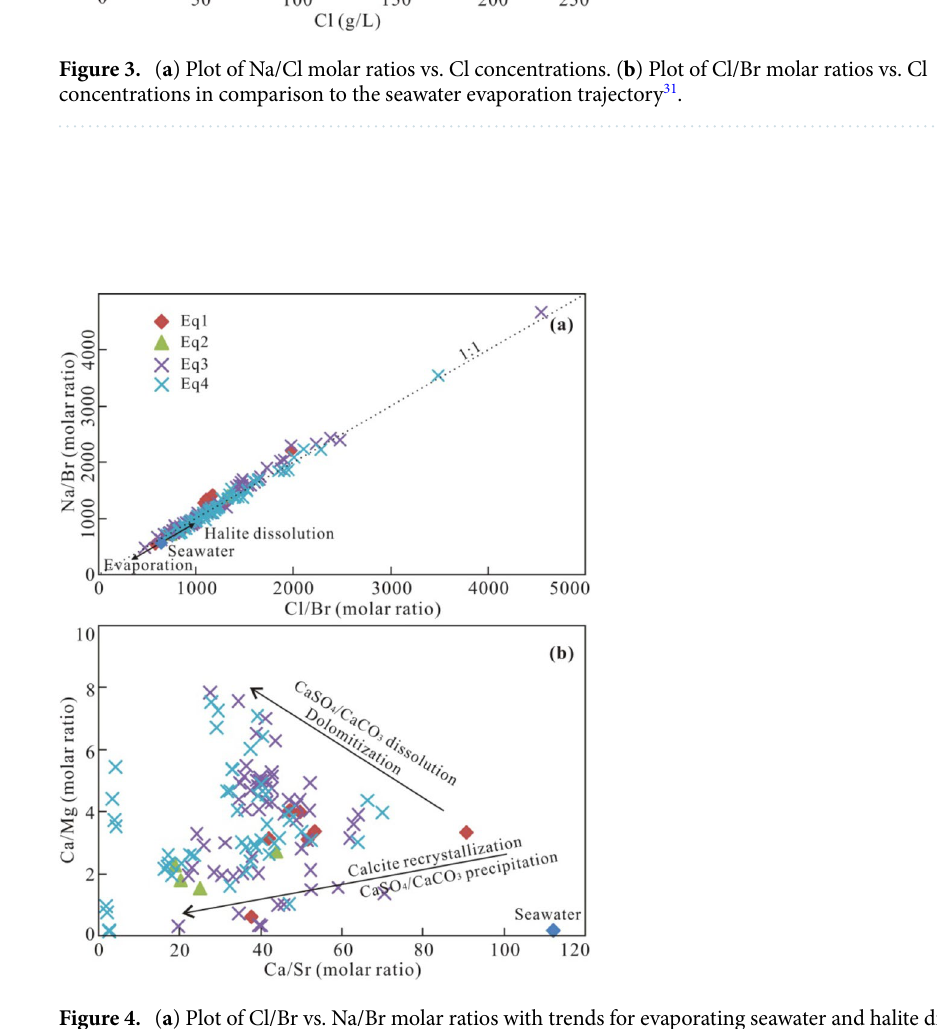
Figure 4. ( a ) Plot of Cl/Br vs. Na/Br molar ratios with trends for evaporating seawater and halite dissolution 32 . ( b ) Plot of Ca/Sr vs. Ca/Mg molar ratios with trends for calcite recrystallization and dolomitization processes 33